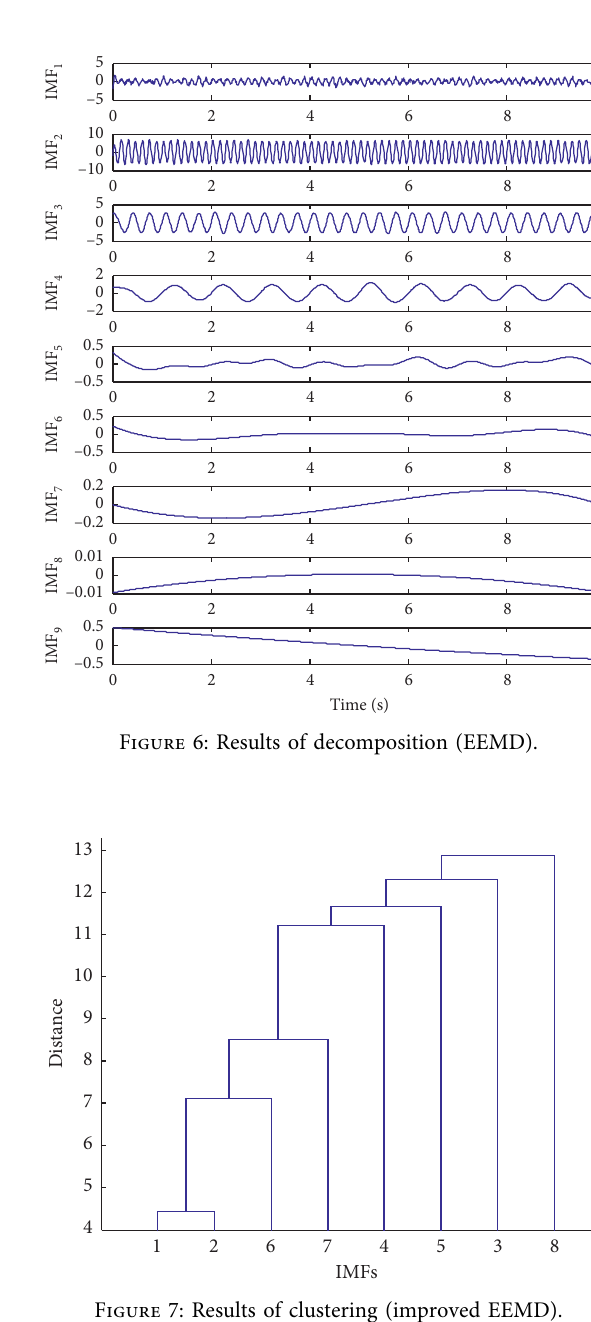
Figure 5: Results of decomposition (improved